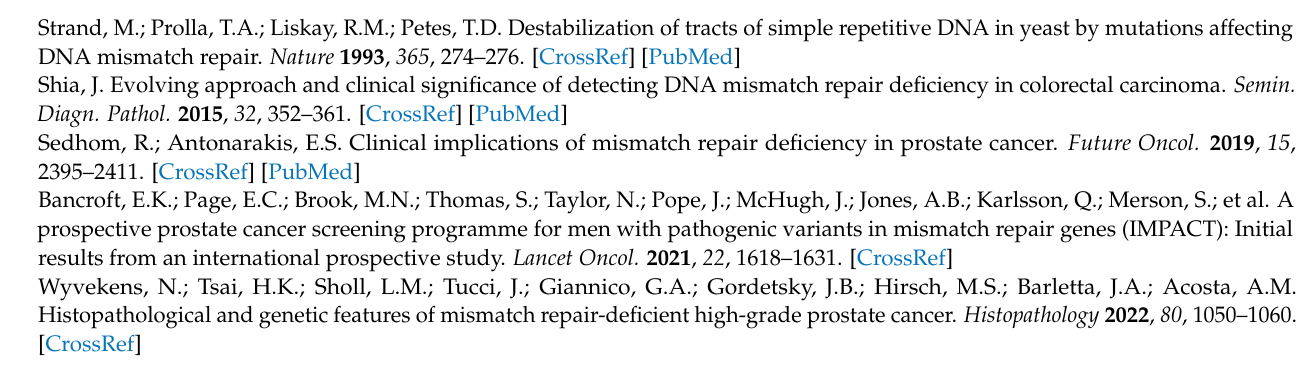
for genomic profiling analyses [14,18,19,38]; Table S1: Candidate Gene Genlist for analysis; Table S2: List of MMR-d primary tumors; Table S3: List of MMR-d metastatic tumors; Table S4: SNV frequency by MMR status in primary tumors; Table S5: SNV frequency by MMR status in metastatic tumors; Table S6: CNV frequency by MMR status in primary tumors (Homozygous Deletion); Table S7: CNV frequency by MMR status in metastatic tumors (Homozygous Deletion); Table S8: CNV frequency by MMR status in primary tumors (High level of amplification); Table S9: CNV frequency by MMR status in metastatic tumors (High level of